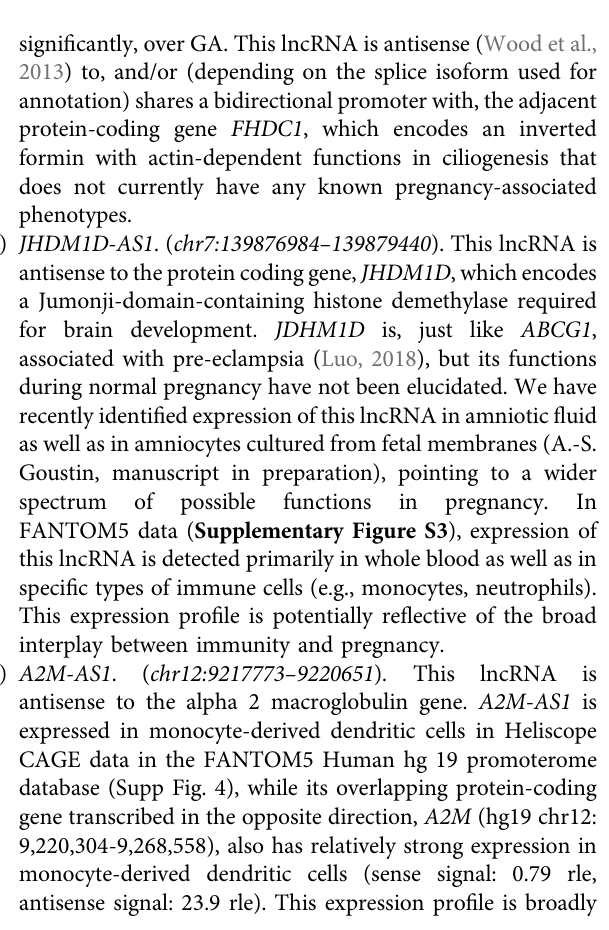
Frontiers in Genetics |